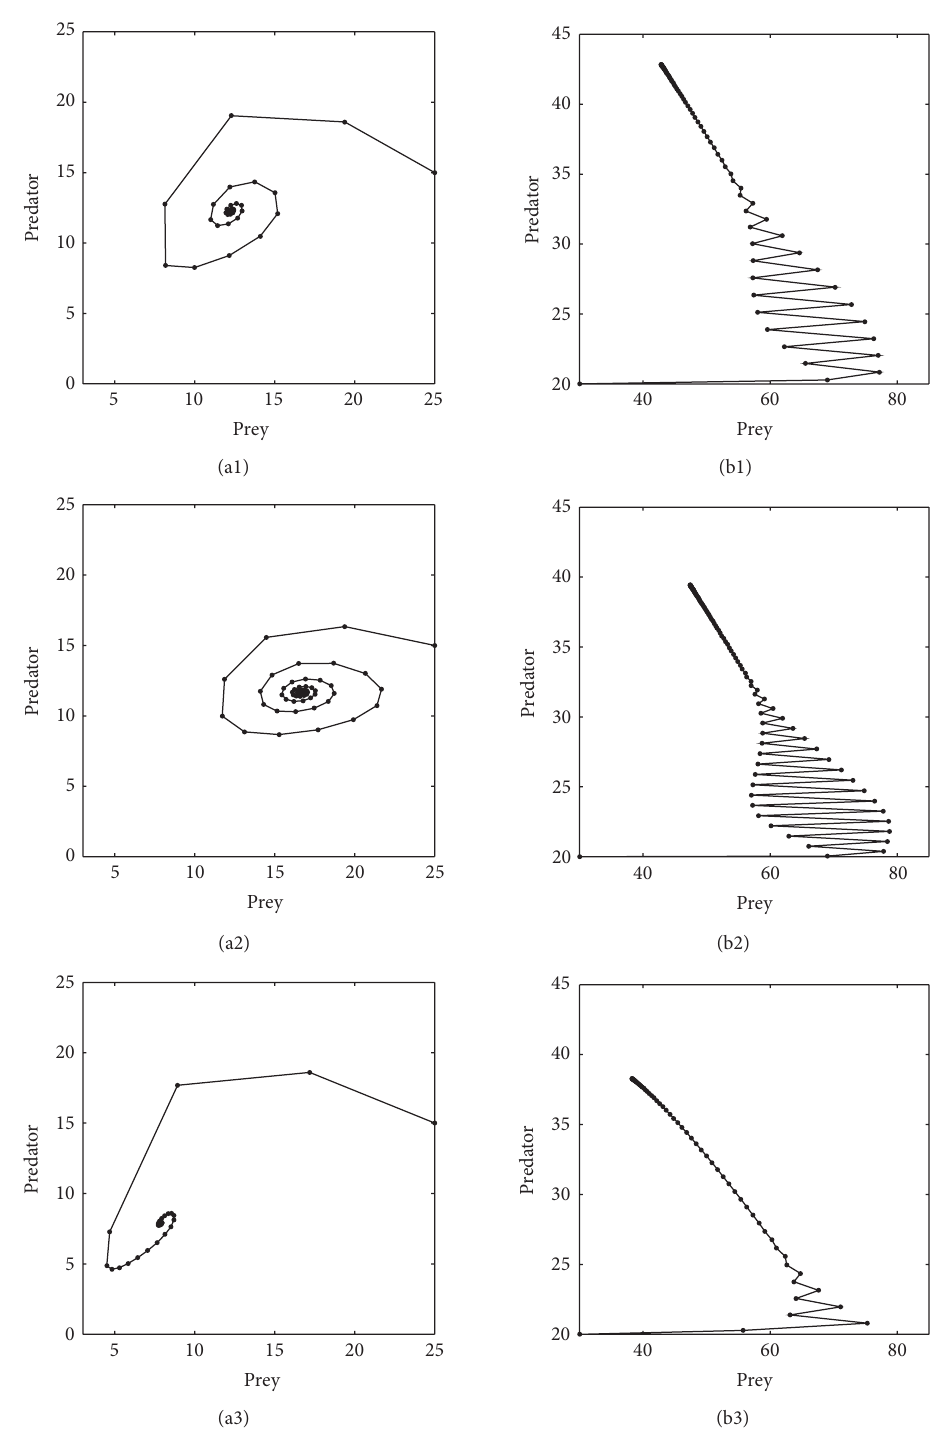
Figure 3: The trajectories of the prey and predator population described by model (1) ((a1) and (b1)), model (11) ((a2) and (b2)), and model (24) ((a3) and (b3)). Parameter values: (a1–a3): 𝑟 = 0.7 , 𝛼 = 0.05 , 𝛽 = 0.6 , 𝐾 = 100 ; 𝑢 1 = 𝑢 2 = 5, 𝑥 0 = 25 , and 𝑦 0 = 15 ; (b1–b3): 𝑟 = 3 , = 𝑢 = 8 , 𝑥 = 30 , and 𝑦 = 20 𝛼 = 0.04 , 𝛽 = 0.04 , 𝐾 = 100 , 𝑢 1 2 0 0